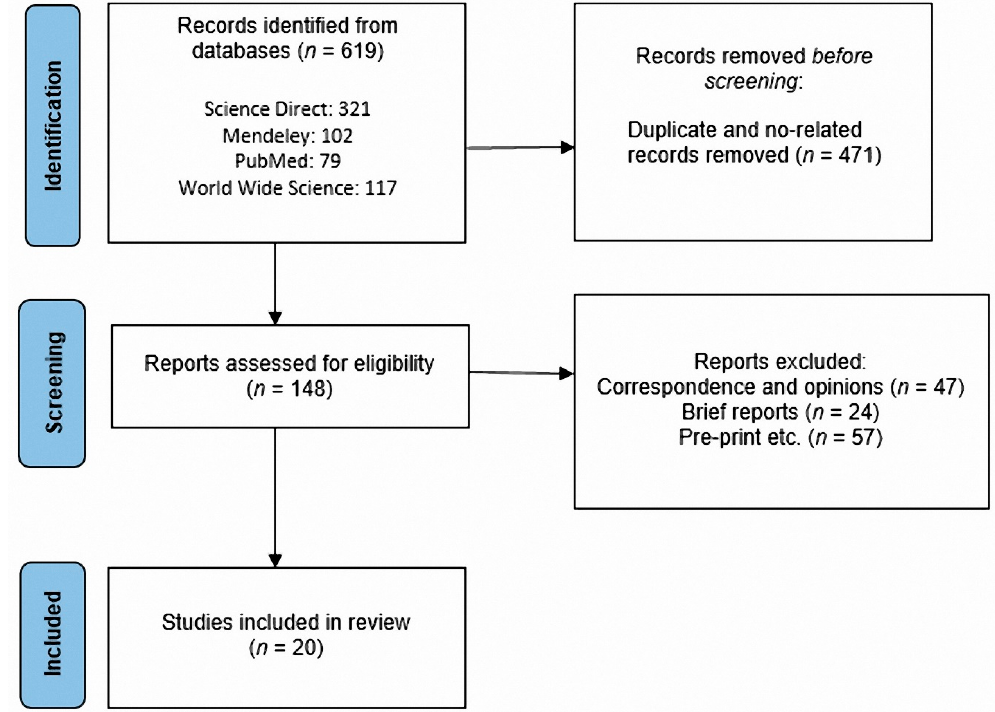
Figure 1. Study identification, PRISMA flowchart.